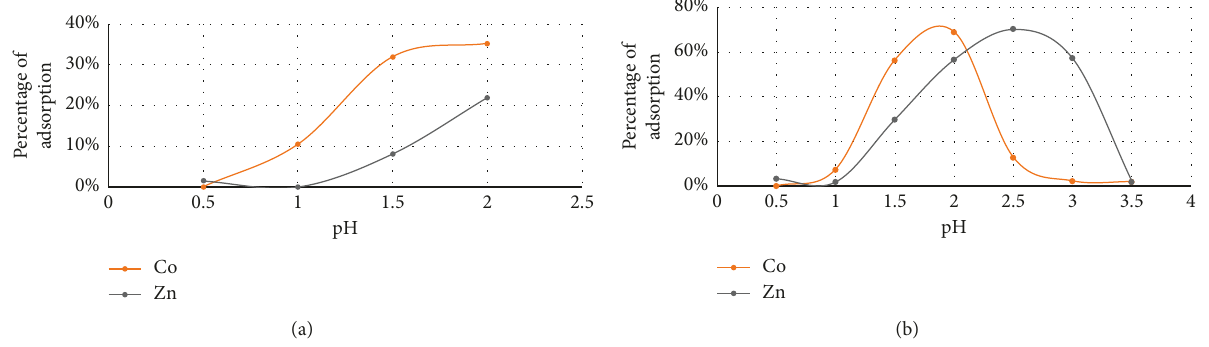
Figure 6: Effect of pH in Solution 3 by the bis-picolylamine resin (a) without and (b) with the pre-reducing process.